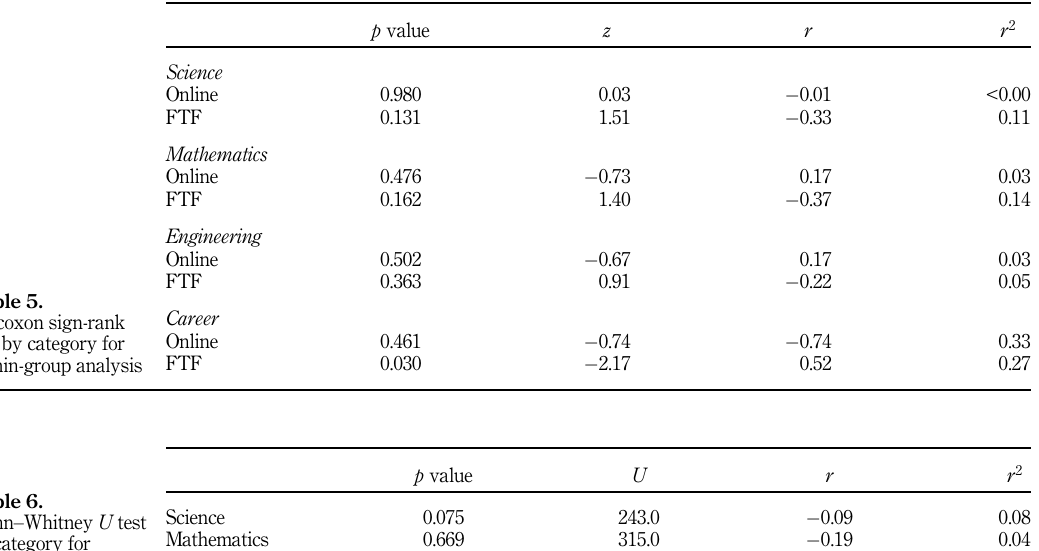
Table 6. Mann – Whitney U test by category for between-group analysis